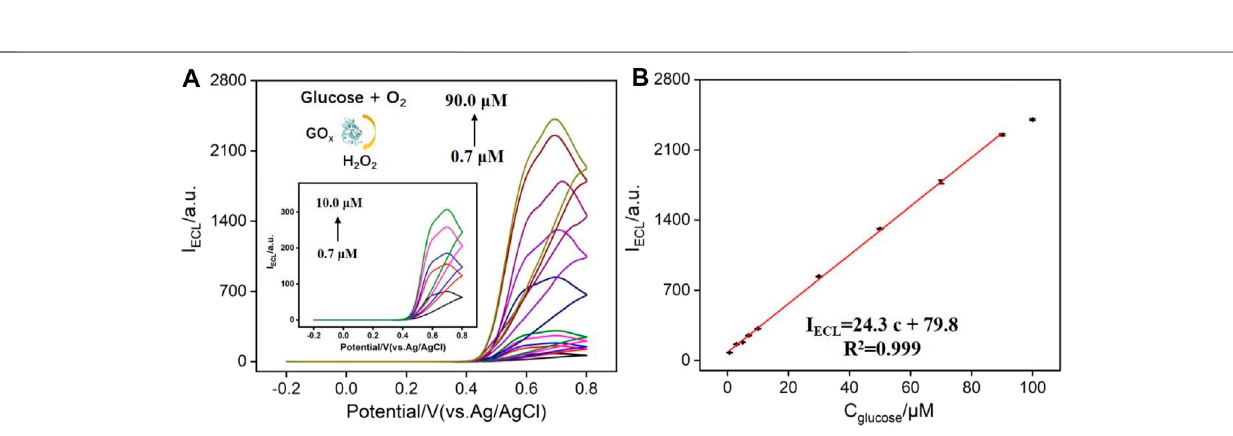
Frontiers in Chemistry |